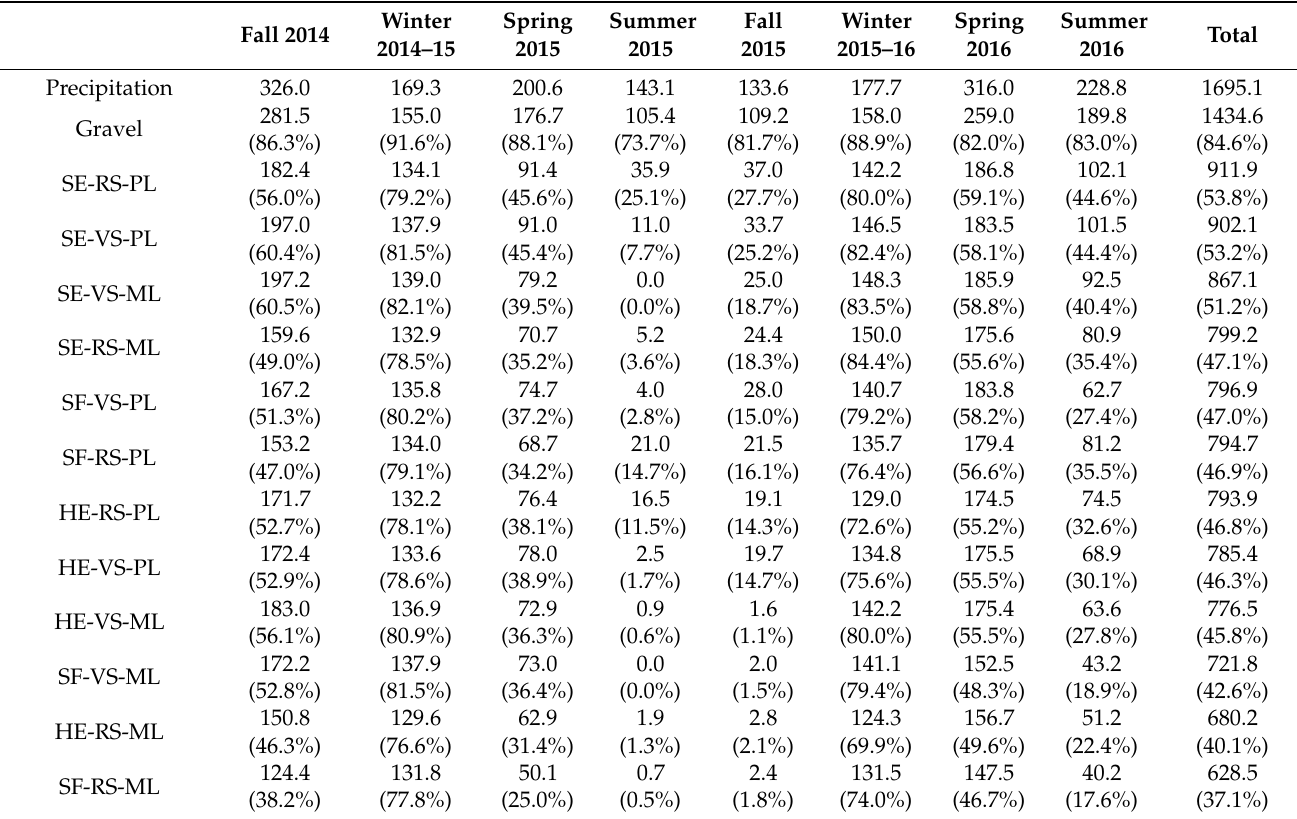
Table 2. Precipitation and outflow volumes (in mm) from each microcosm type (in brackets is the percentage of